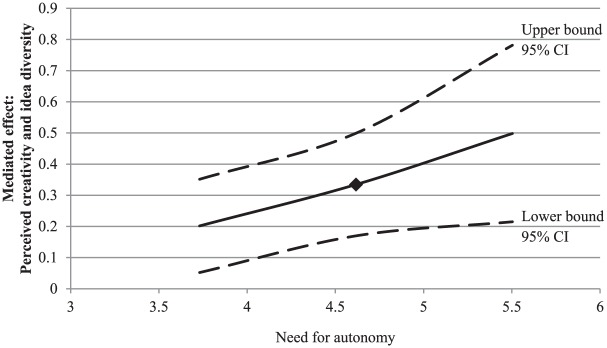
Study 1: A plot of the conditional indirect effect of input novelty
on idea diversity through perceived creativity, conditioned on the
moderator (need for autonomy), with 95% confidence bands.Note. The square indicates the mean level of the
need strength. CI = confidence interval.